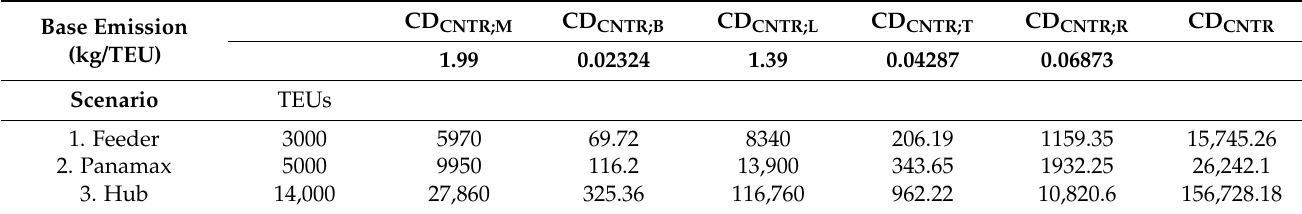
Table 2. Results of total carbon emission for the terminal container of the Port of Augusta (kg).